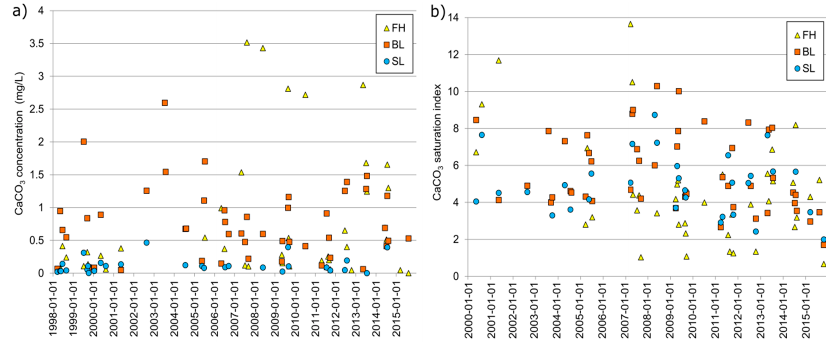
Figure 7. Time series (1998 to 2015) of ( a ) in situ measured CaCO 3 concentrations (mg/L); and ( b ) the calculated CaCO 3 saturation index (SI) in FH, BL, SL lakes.